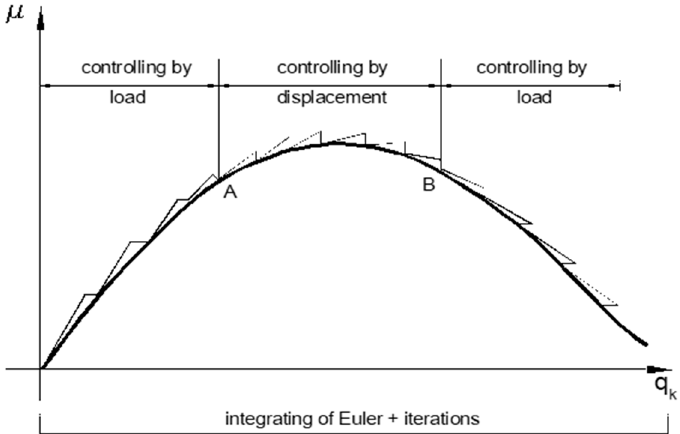
Figure 4. Control of iteration around extreme points.